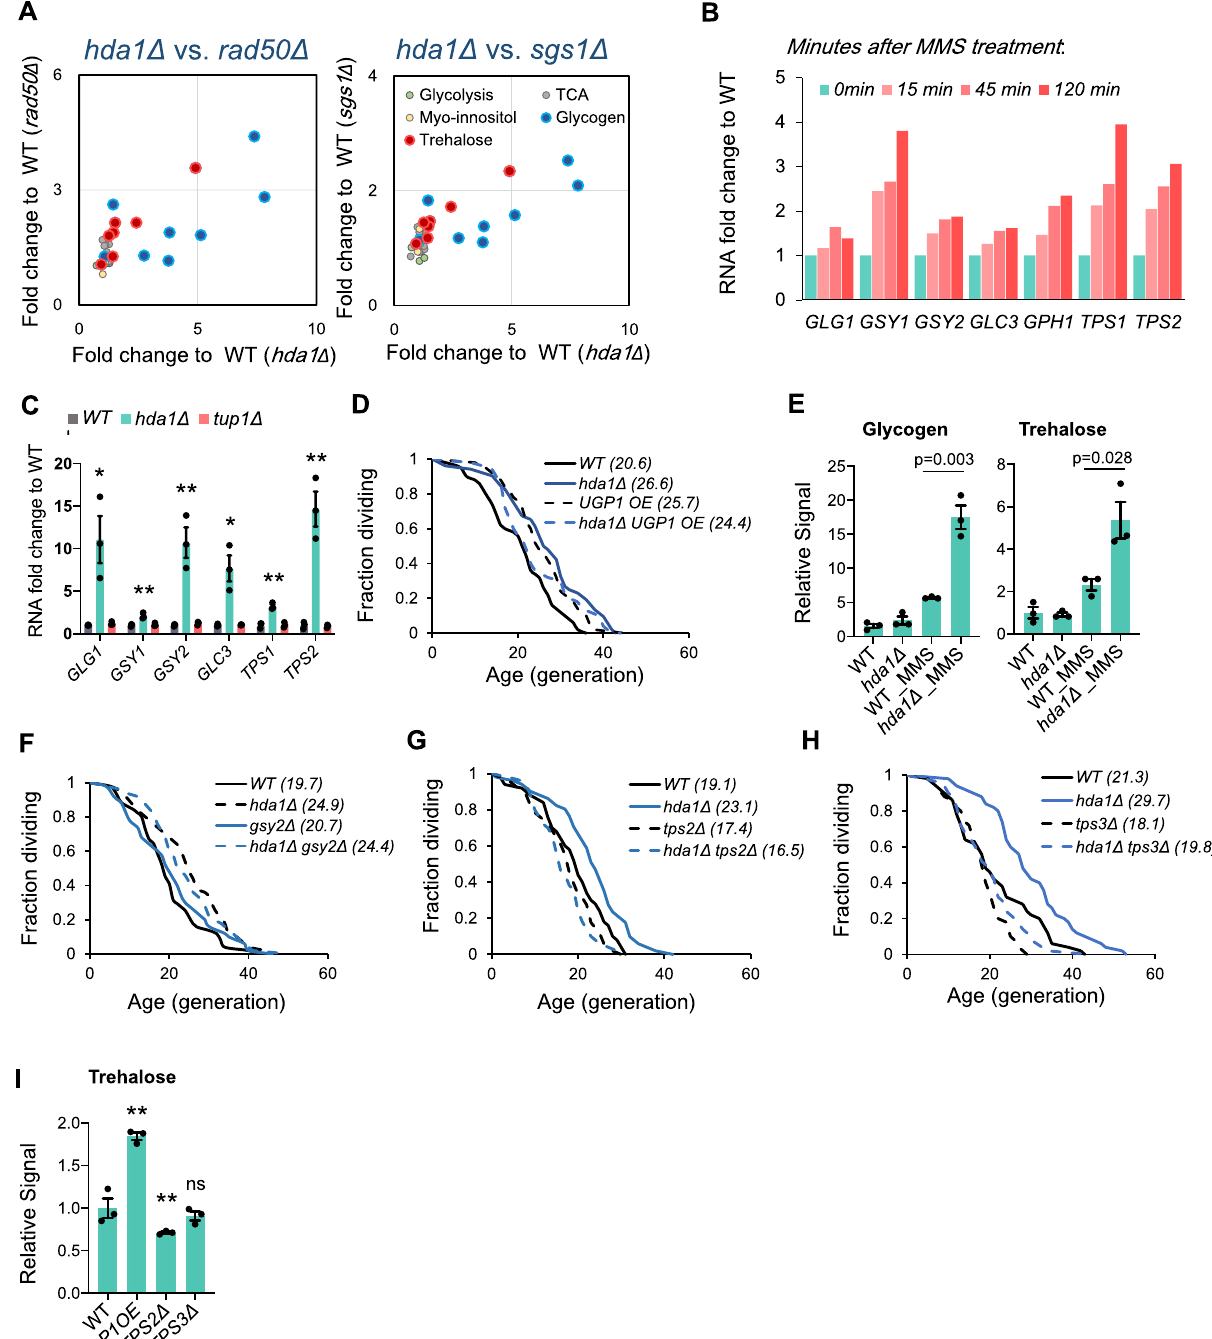
Fig. 5 Longevity of HDA mutants is dependent on trehalose metabolism. A Transcriptome analysis of fi ve carbohydrate metabolism related pathways in hda1 Δ , rad50 Δ , and sgs1 Δ . B RNA level of designated glycogen and trehalose metabolism genes in hda1 Δ and tup1 Δ , data from Reimand et al. 45 . C RNA level of designated glycogen and trehalose metabolism genes in hda1 Δ and tup1 Δ , measured by quantitative real-time PCR. Error bars represent SEM, n = 3. p -value calculated by two-sided T-test, * p <0.05, ** p <0.01. Exact p -values are GLG1 : 0.022; GSY1 : 0.007; GSY2 : 0.006; GLC3 : 0.012; TPS1 : 0.002; TPS2 : 0.003. D RLS of WT, hda1 Δ , UGP1OE , and hda1 Δ UGP1OE . E Glycogen and trehalose levels in WT and hda1 Δ , with designated time of treatment under MMS. Error bars represent SEM, n = 3. F RLS of WT, hda1 Δ , gsy2 Δ , and hda1 Δ gsy2 Δ . G RLS of WT, hda1 Δ , tps2 Δ , and hda1 Δ tps2 Δ . H RLS of WT, hda1 Δ , tps3 Δ , and hda1 Δ tps3 Δ . I Trehalose levels in WT, UGP1OE , tps2 Δ and tps3 Δ . Error bars represent SEM, n = 3. Exact p -values are UGP1OE : 0.002; tps2 Δ : 0.002 and tps3 Δ : 0.50. See also Fig.